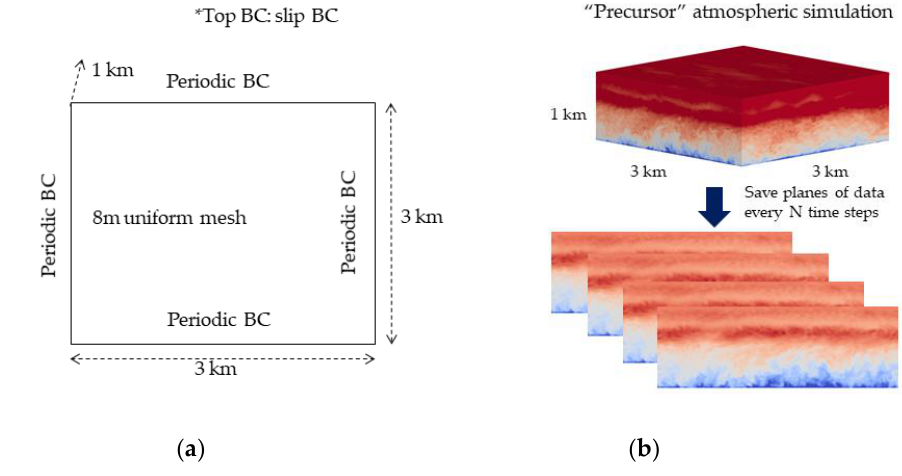
Figure 1. ( a ) horizontal projection of computational domain, ( b ) precursor simulations to generate turbulent inflow boundary data. BC: boundary condition.